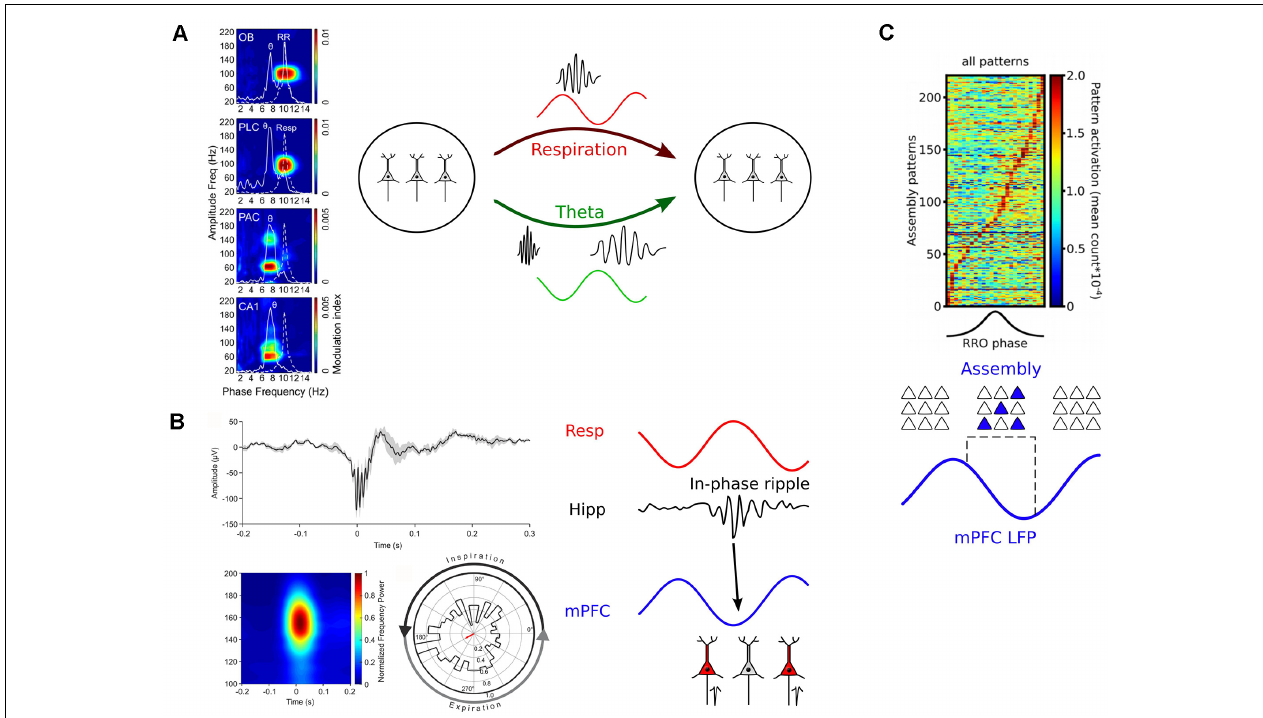
FIGURE 5 | Mechanisms of how breathing might impact cognition. (A) Left: RR entrains fast gamma activities across brain circuits. PLC, prelimbic cortex; PAC, parietal cortex. Reprinted from Zhong et al. (2017). Right: Respiration and theta oscillations provide timing signals for gamma oscillations of different frequencies (Biskamp et al., 2017; Zhong et al., 2017). (B) Left: Respiration paces ripples. Top: Example of a hippocampal ripple. Bottom: Average ripple power spectrum (left) and distribution of ripple events as a function of respiration phase. Reprinted from Liu et al. (2017) under CC BY 4.0. Right: RR-entrained ripples might enable efficient communication between hippocampal and neocortical circuits (Liu et al., 2017; Karalis and Sirota, 2018). (C) Top: Neuronal assemblies activate during the descending part of the prefrontal respiration-related oscillation (RRO). Reprinted from Folschweiller and Sauer (2021) under CC BY 4.0. Bottom: RR creates time windows for assembly activation and might thus orchestrate the joint activity of distributed assembly members or facilitate assembly stabilization by offline reactivation (Dejean et al., 2016; Folschweiller and Sauer, 2021).